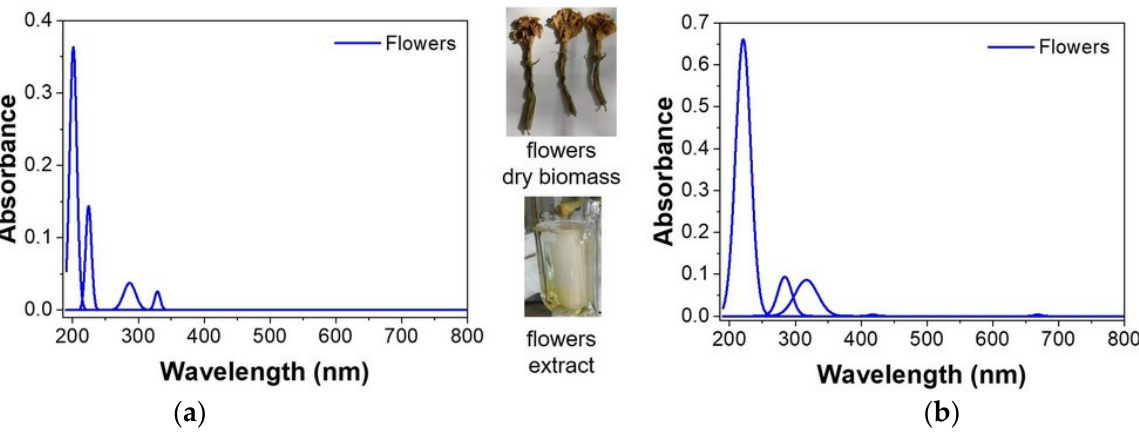
Figure 7. UV–VIS profile absorption spectra after deconvolution for Datura innoxia flowers matrix in ethanol extract ( a ) and 1-butanol extract ( b ).